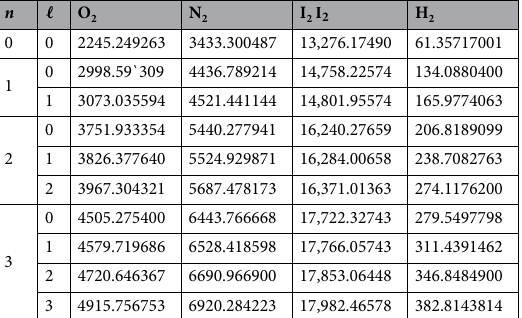
Table 7. Variance in position space of some diatomic molecules with (cid:31) = C = 1 for various n and ℓ .